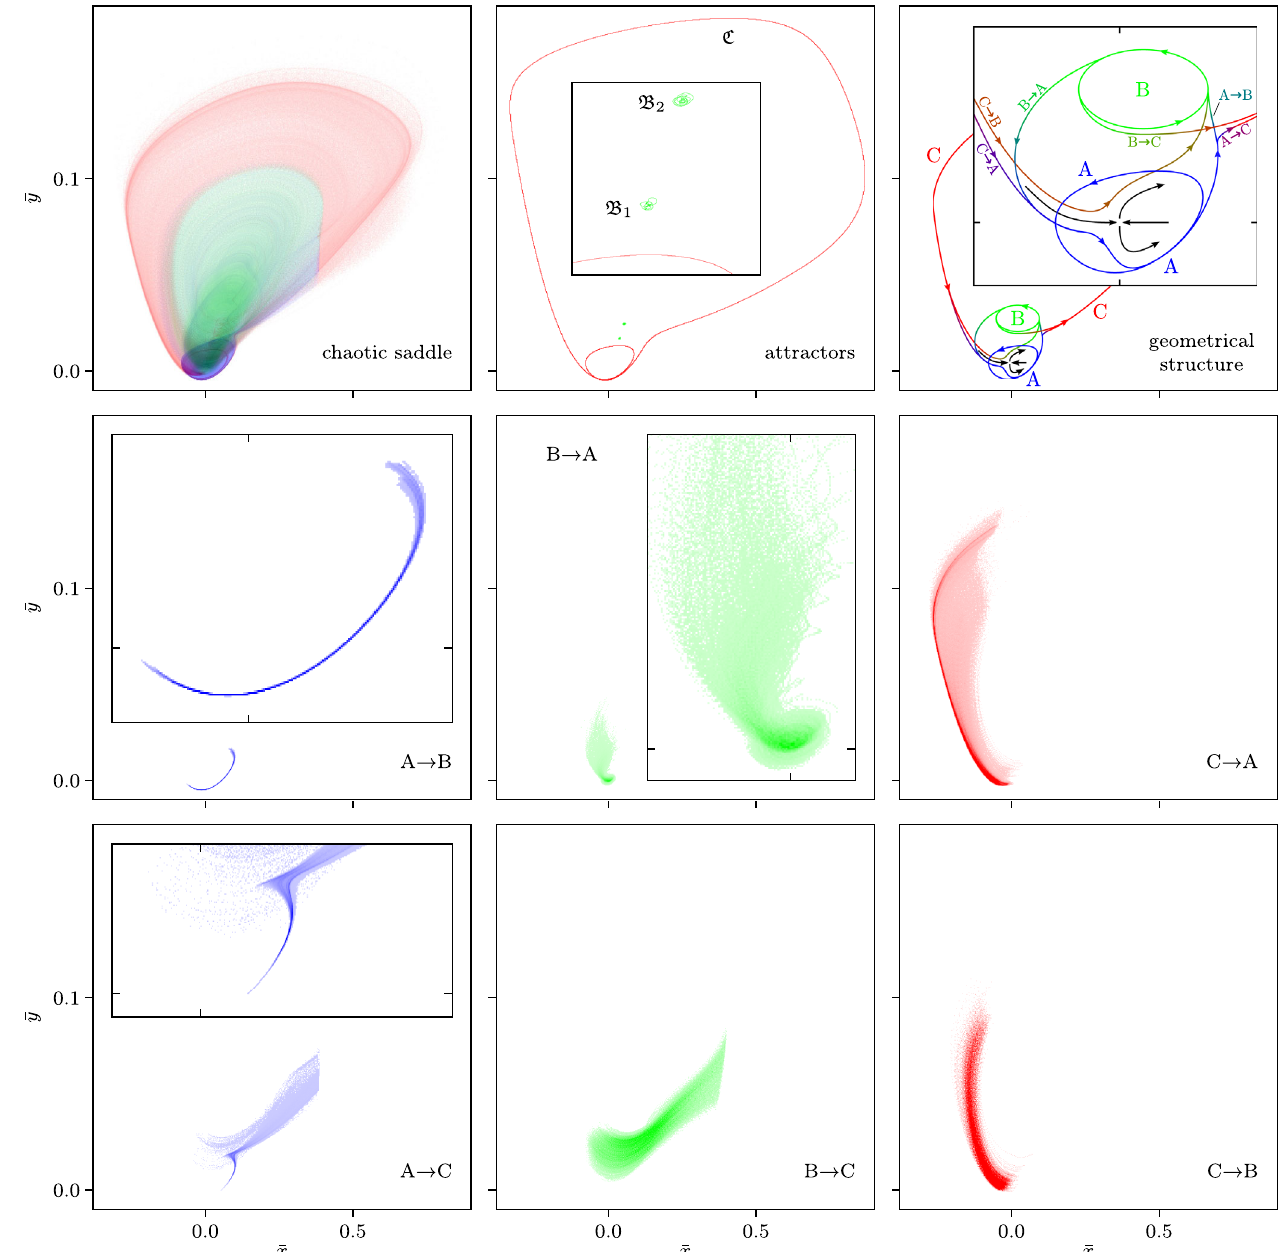
FIG. 5. Top left: Scatter plot of ¯ x and ¯ y for 100 trajectories (the same as used for Fig. 4 and Table I) with the point color indicating the respective pattern (blue, A; green, B; red, C), excluding trajectory segments from the attractors. Top middle: Same, only with data from the attractors B (traveling waves) and C ( 1 1 global oscillations). There are two distinct attractors for traveling waves ( B 1 and B 2 ), one manifested as a horizontally traveling wave front and one manifested as a diagonally traveling wave front. Note that their phase-space projections are almost a point, because ¯ x and ¯ y change only little over one period. Attractor A is not observed for this realization of the coupling topology and control-parameter inhomogeneity. Middle and bottom row: Same with data only from 50 time units before switchings between patterns. Top right: Sketch of stable and unstable manifolds (black) associated with the fix point at the origin and typical trajectories (colors encode patterns as above; trajectories corresponding to switchings are shown in blended colors). All panels: Insets show zooms of the respective plots. Trajectories are generally directed